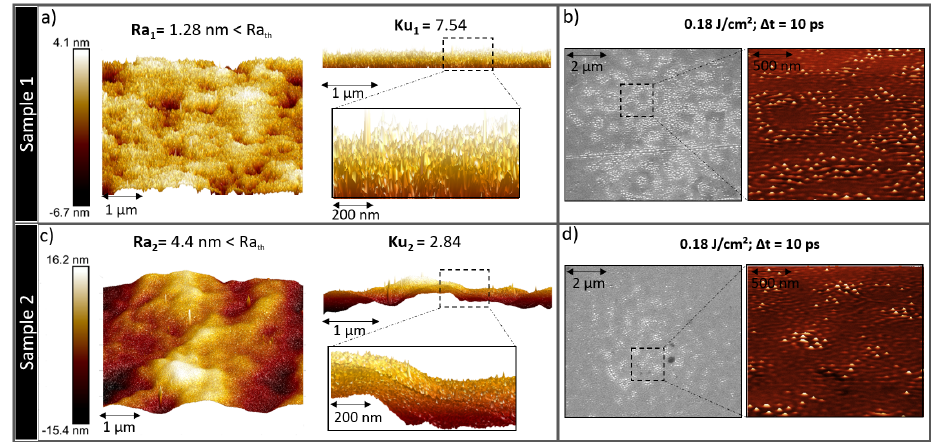
Figure 5. Initial surface topography of two different samples polished by different procedures (Mechanical polishing in ( a ) and Electrochemical in ( c )). Arithmetic roughness (Ra) and Kurtosis (Ku) were measured and compared for both samples. ( b , d ) 2D and 3D SEM images of ( a , c ) respectively after laser irradiation. The crucial role of initial type of roughness is observed by comparing the nanostructures concentration in the